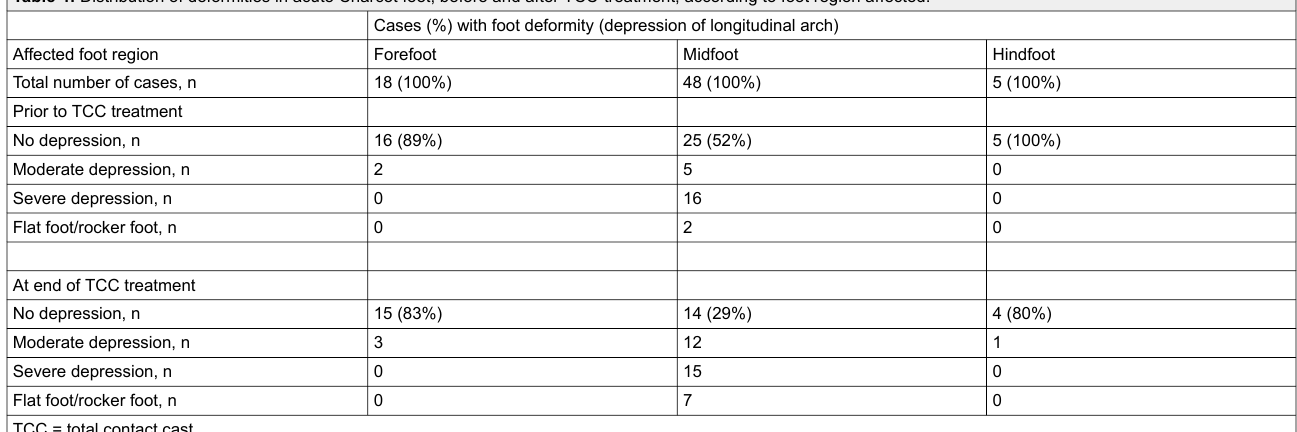
Table 4: Distribution of deformities in acute Charcot feet, before and after TCC-treatment, according to foot region affected. Cases (%) with foot deformity (depression of longitudinal